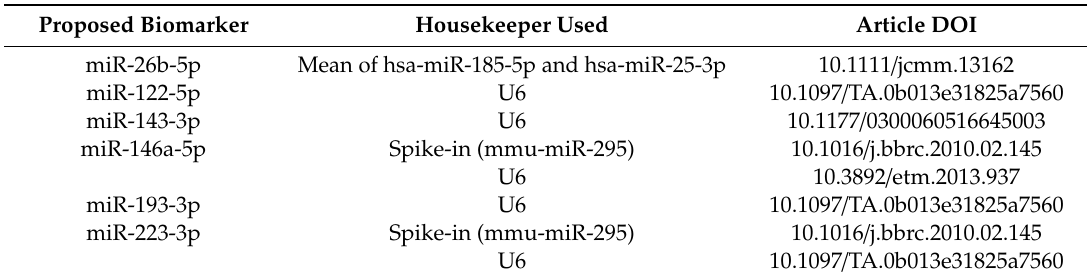
Table 2. miRNAs proposed in literature as sepsis